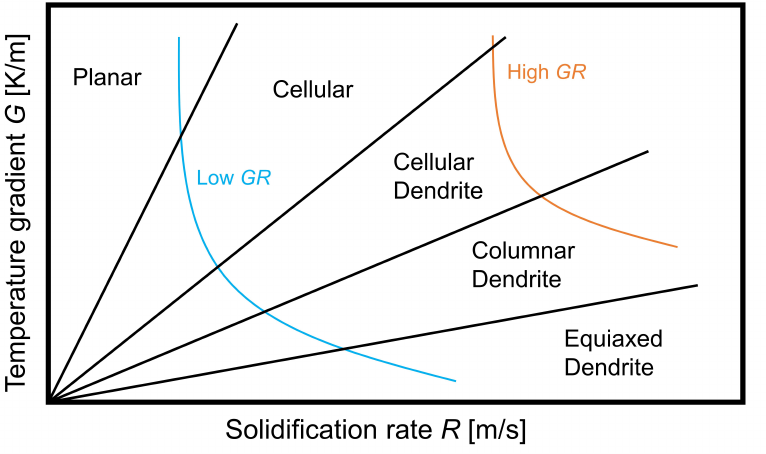
Figure 2. Effect of temperature gradient G and solidification rate R in the melt pool on solidification morphology and microstructural fineness. Reproduced with permission from Lippold; published by John Wiley & Sons, 2015